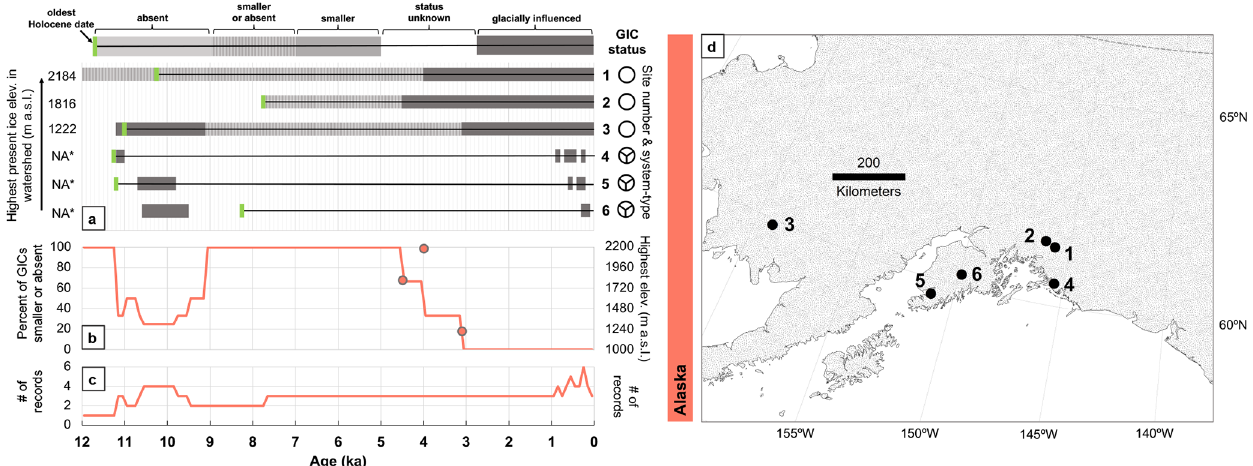
Figure 3. Holocene lake-based GIC records from Alaska. (a) Shaded bars show a schematic view of GIC fluctuations reconstructed from lake sediments between 12 and 0ka. Dark gray bars denote glacially influenced sediment, medium gray bars denote GICs smaller than present but not absent, and light gray bars denote GIC absence. Striped bars denote GICs smaller than present or absent (where these two states cannot be distinguished from one another), and blank sections denote times when glacier or ice cap status is unknown or unclear. Colored bars indicate the oldest reported Holocene age in each record (green: 14 C-dated plant or aquatic macrofossil, yellow: paleomagnetic secular variation – PSV, blue: 14 C-dated marine macrofossil, pink: bulk sediment, purple: tephra, black: other). Values on the left show each watershed’s highest present ice elevation in meters above sea level (ma.s.l.). (b) The line shows the percent of this region’s studied GICs smaller than present or absent from 12 to 0ka. Open dots show the timing of earliest GIC regrowth and solid dots the timing of sustained GIC regrowth in the middle to late Holocene versus each watershed’s highest present ice elevation. (c) The number of records from this region from 12 to 0ka and (d) study locations. Sites are as follows: 1. McKay and Kaufman (2009) (Greyling Lake, unnamed glaciers); 2. McKay and Kaufman (2009) (Hallet Lake, unnamed glaciers); 3. Levy et al. (2004) (Waskey Lake, unnamed glaciers); 4. Zander et al. (2013) (Cabin Lake, Sheridan Glacier); 5. LaBrecque and Kaufman (2016) (Emerald Lake, Grewingk Glacier); 6. Daigle and Kaufman (2009) (Goat Lake, North Goat Glacier). We note that the oldest radiocarbon age from Greyling Lake is pre-Holocene. We report the oldest Holocene age. ∗ Lake records 4, 5, and 6 are considered threshold records and do not receive glacial meltwater at present. Thus, the non-glacial–glacial transitions may not precisely represent the timing of the glacier’s response to climate